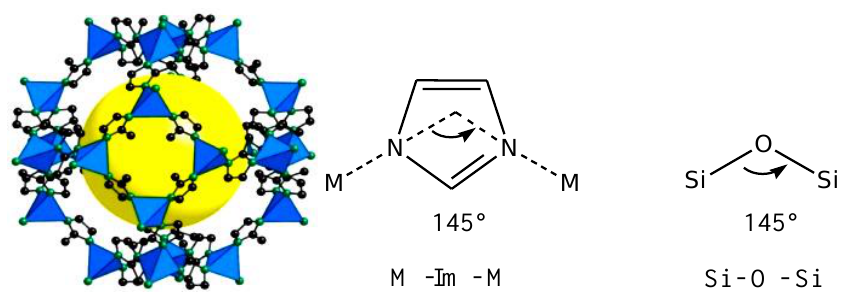
Figure 4. The structure of the ZIF-8 zeolite imidazolate framework. The M–Im–M (2-methylimidazolate– metal angle in ZIF structures is similar to the angle between Si–O–Si bonds in zeolites (145 ◦ ). Reprinted with permission from reference [61]. Copyright 2010 American Chemical